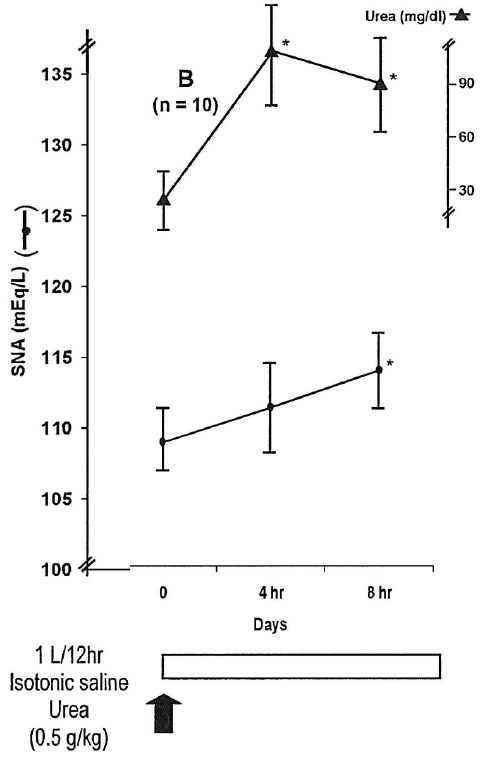
Figure 1. Evolution of SNa and urea (mean ± SD) each four hours in 10 patients with severe hyponatremia (<115 mEq/L) related to SIADH of various origins (adapted from reference [25] with permission from the authors, Decaux et al.